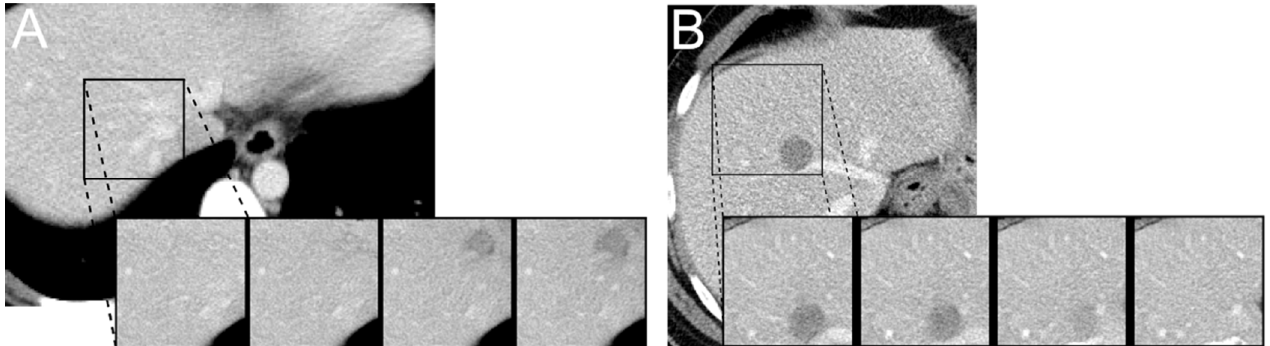
Figure 3. Synthetic insertion ( A ) and removal ( B ) of a liver lesion. The four insets each display generator output and a linear interpolation of latent code with 25, 75, and 100% from left to right. Each inset is 96 × 96 pixels in size, corresponding to an approximate physical size of 96 × 96 mm.